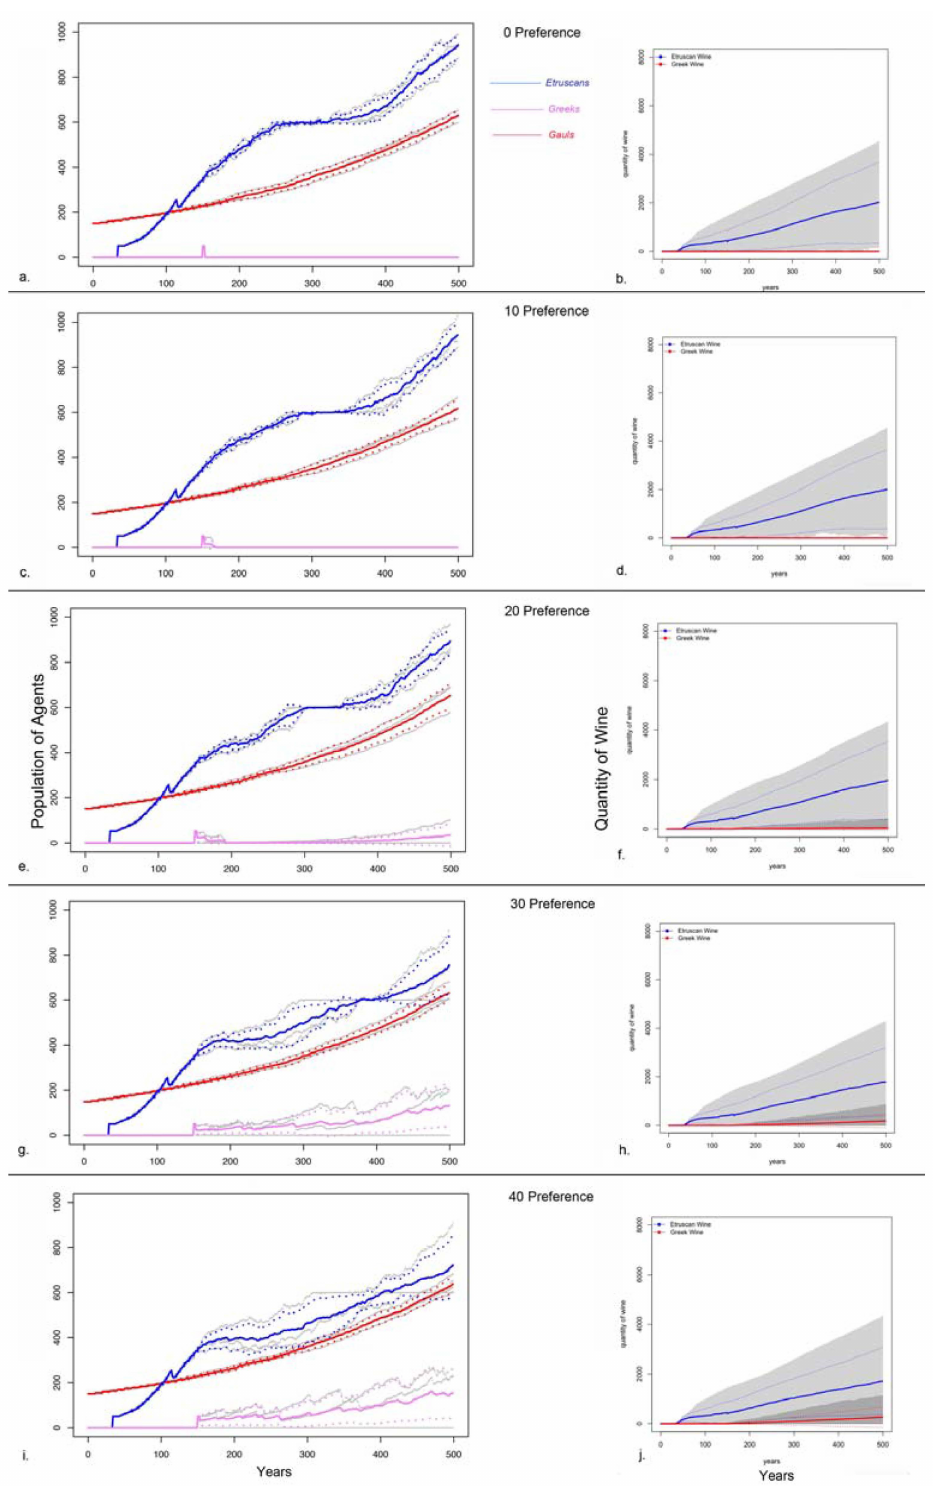
Figure 4. ( a – j ) Response of population and artifact type based on preference value, beginning with a preference of 0 (in favor of Etruscans) and ending at a preference value of 40 (almost equal preference, still in favor of Etruscans). Preference values are reported in the middle of each tile, corresponding to the values on the left and the right. Left side of tiled figure corresponds to population, while the right side corresponds to the artifact assemblage. Solid colored lines denote the mean, while dotted colored lines denote one standard deviation above and below the mean. Grey lines indicate overall variation of output in